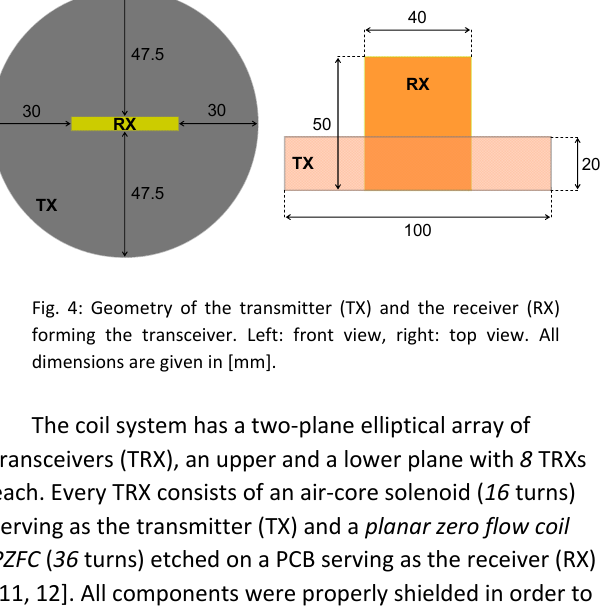
Fig. 5: Experimental setup and geometry of the coil system. Top: top view, bottom: long-side view; TRX: transceiver. For the sake of clarity, the lower TX2 was made transparent and its 3D view was deactivated. The red marker in the figure is either an active or a passive one, depending on the experiment. The dotted, curved blue arrow symbolizes an unwanted (rotational) movement of the measured medium. All dimensions are given in